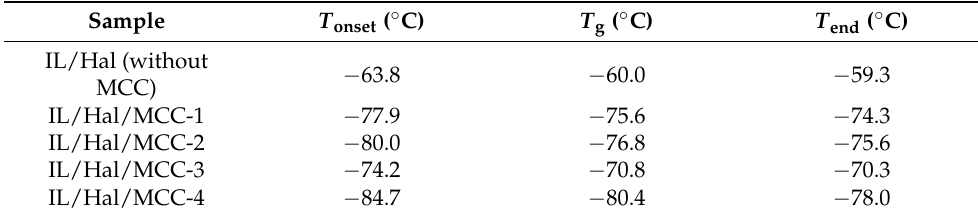
Table 3. The effect of cellulose content on the characteristic phase-transition temperatures for the BMImAc/Hal/MCC ionogels.